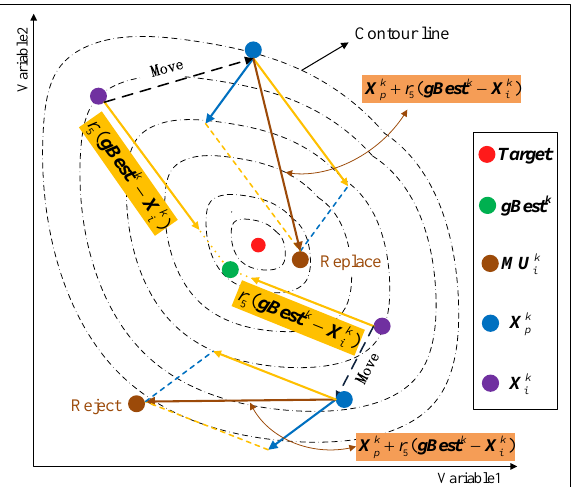
Figure 2. Sketch map of the random mutation strategy.